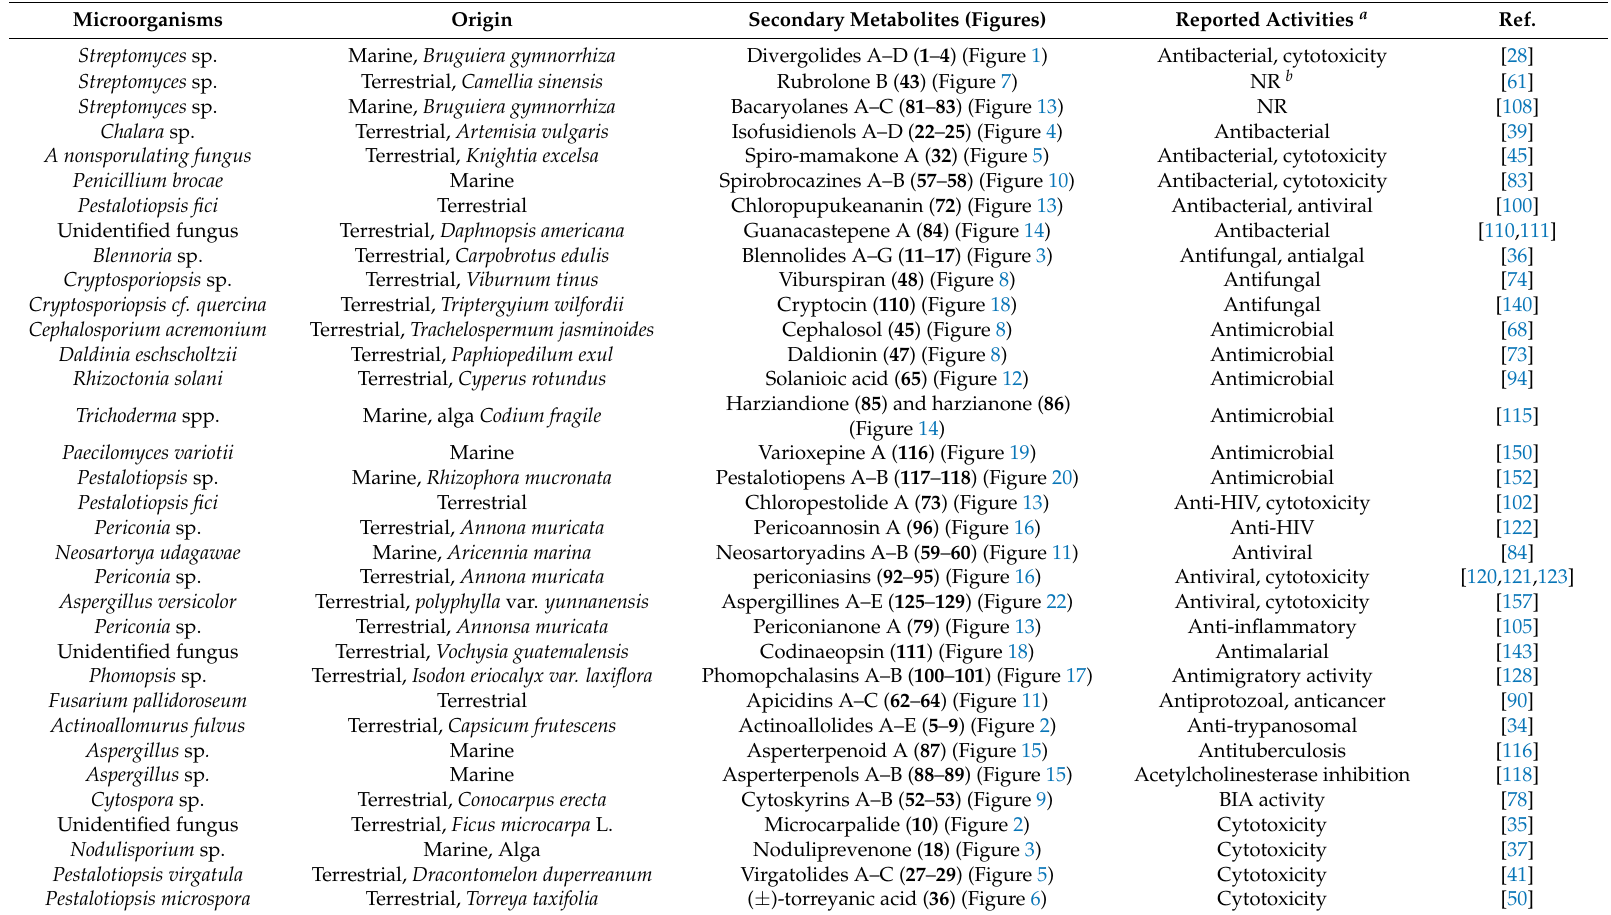
Table 1. Structurally novel natural products from endophytic bacteria or